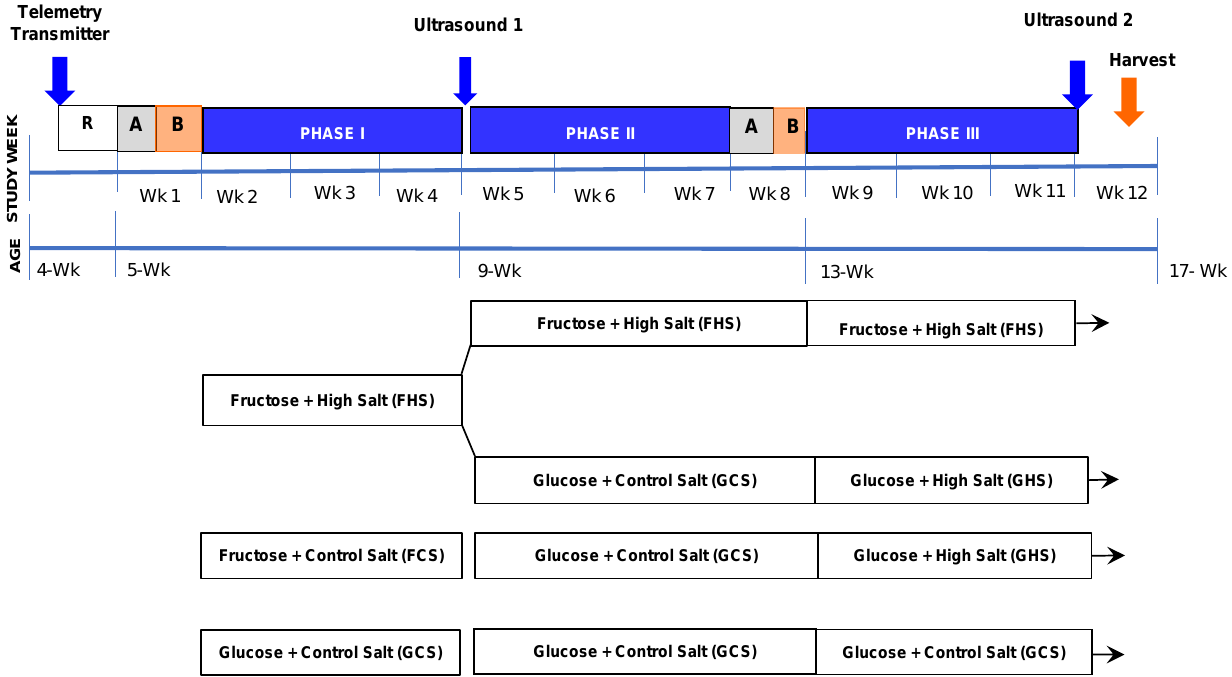
Figure 1. Schematic of the Timeline of Experimental Protocols and Study Phases. Rat age and study week are depicted across the timeline. R, recovery period; A, acclimation to metabolic cages; B, baseline. Surgery for telemetry transmitter placement and ultrasound studies are as indicated. Groups are subsequently depicted by their sugar-salt intake in Phases I I and III.